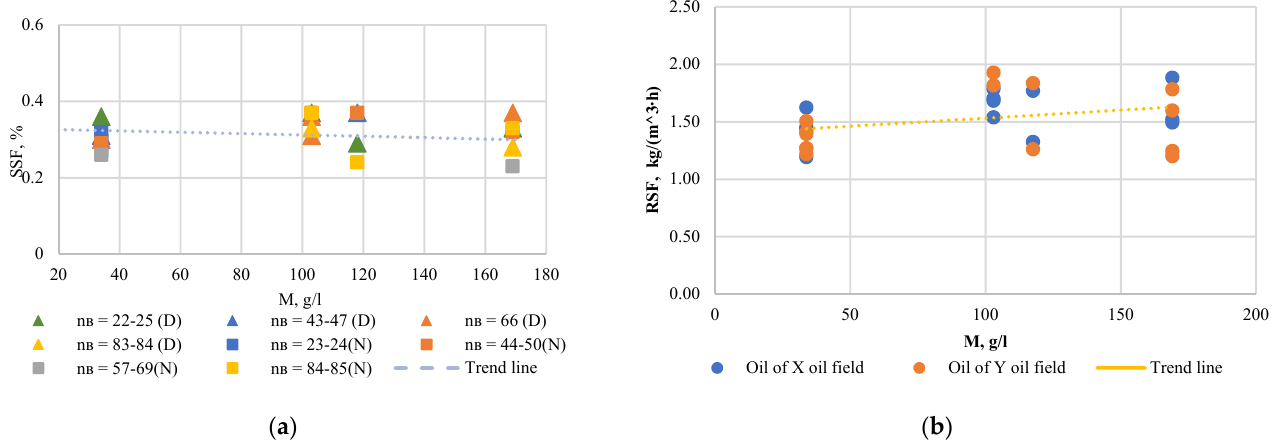
Table 5. RSO results of laboratory investigation.